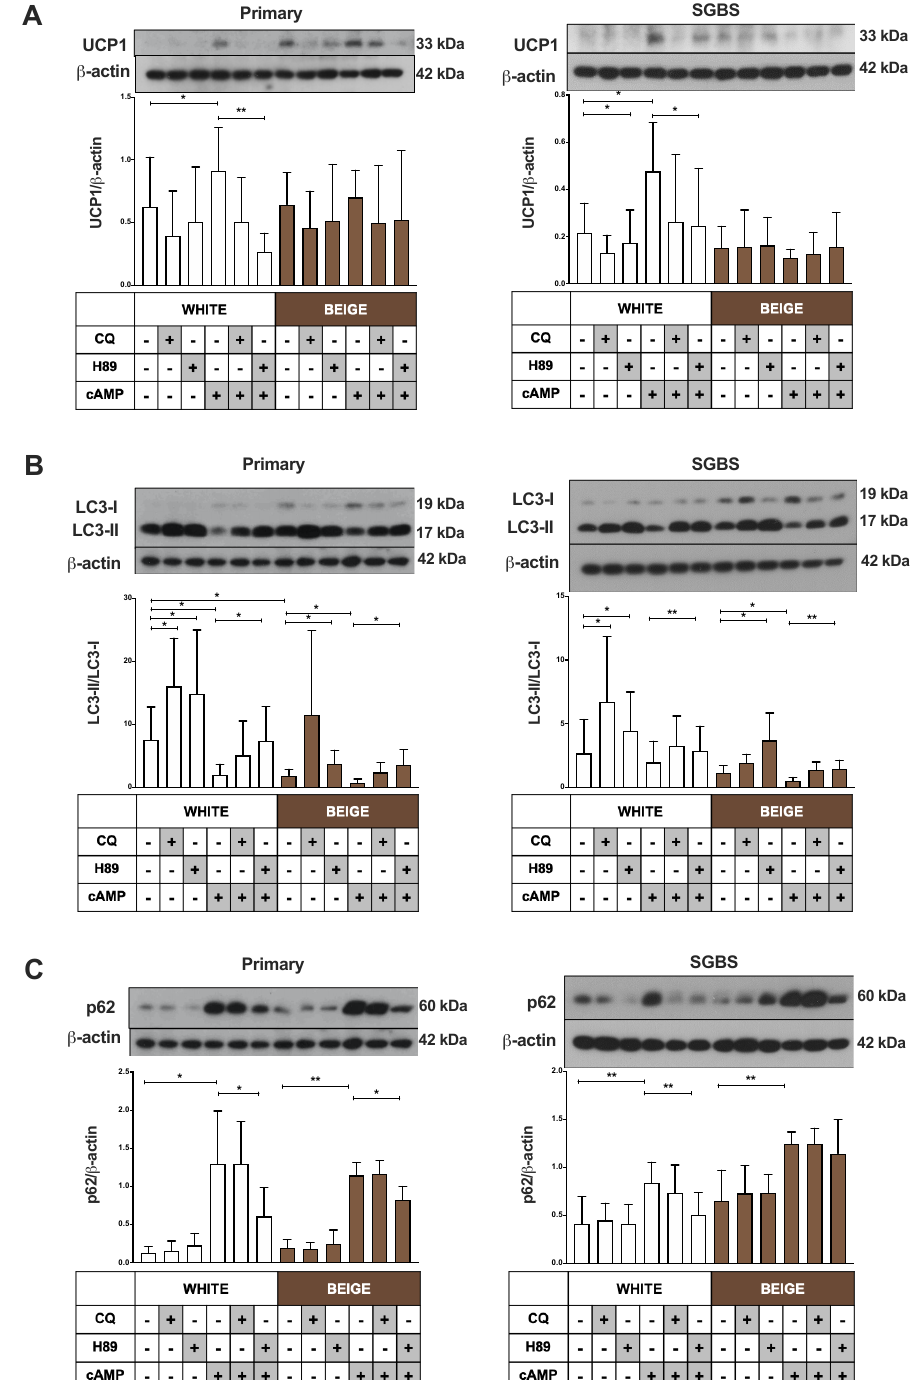
Figure 4. The inhibition of the Protein kinase A (PKA) pathway by H89 alleviates the e ff ect of cAMP on autophagy / mitophagy and thermogenesis. Adipocytes were di ff erentiated as in Figures 1–3, and treated with CQ (25 µ M, 1 h), H89 (50 µ M, 1 h) or cAMP (500 µ M, 6 h). Representative immunoblots and densitometry analysis of ( A ) UCP1 ( n = 4), ( B ) LC3-II / LC3-I ratio ( n = 5), and ( C ) p62 ( n = 5) protein expression in primary (left) and SGBS cells (right) normalized to β -actin. Results are expressed as mean ± SD. Statistics: two-tailed paired student t -test; * p < 0.05; ** p <